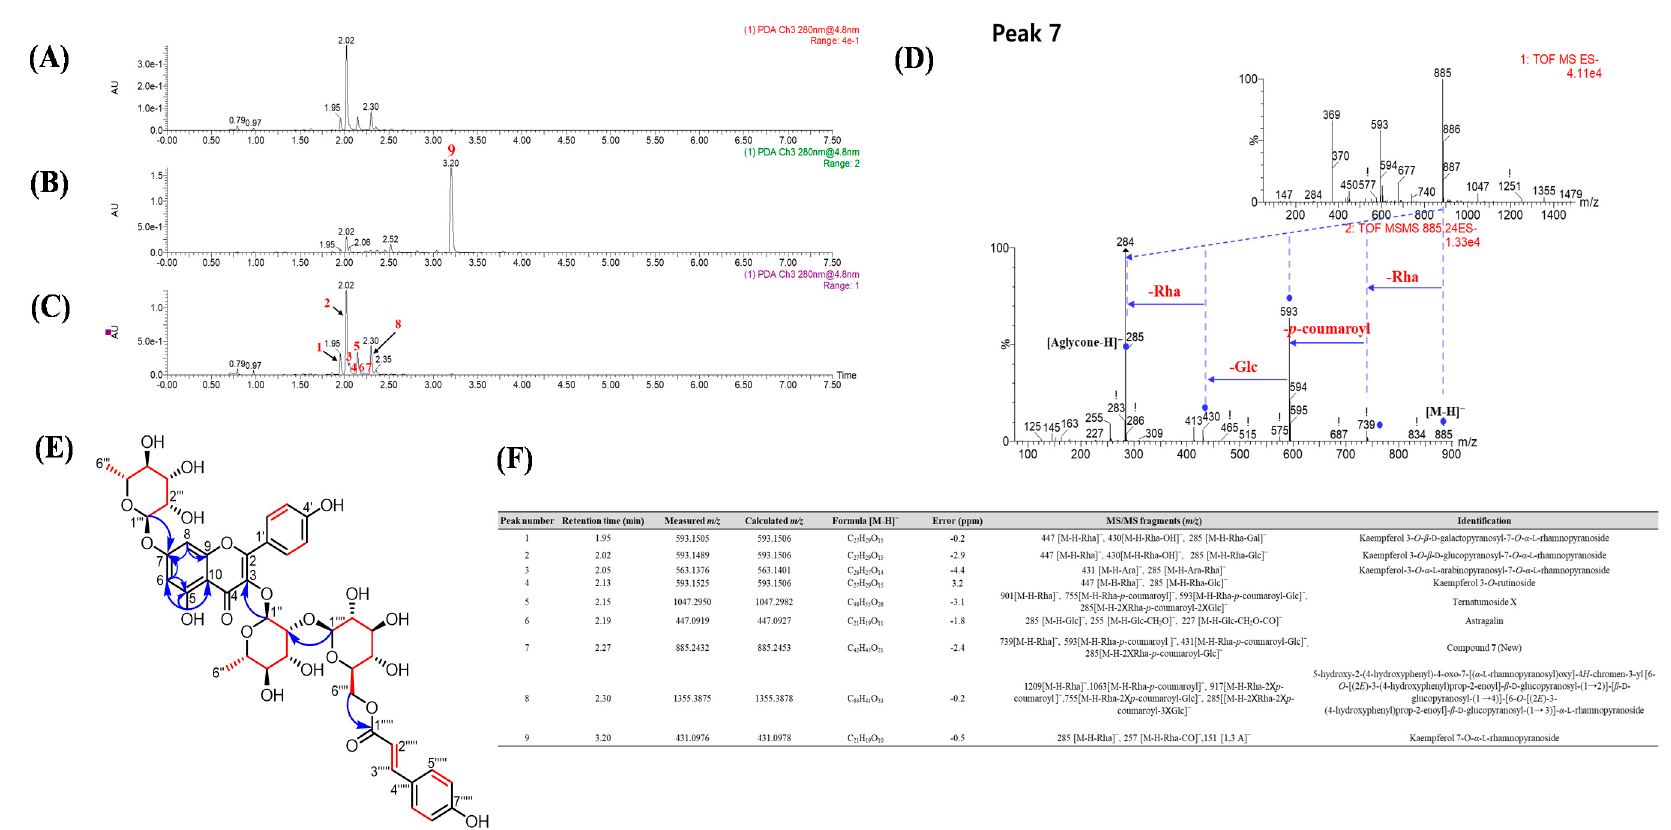
Figure 2. DAD (UV) chromatograms of ( A ) the crude extract, ( B ) the ethyl acetate (EA)-soluble fraction, and ( C ) the n -BuOH-soluble fraction of N. lappaceum seeds at 280 nm. Nine compounds ( 1 – 9 ) were quantitatively analyzed by UHPLC / ESI-qTOF-MS / MS in negative ion mode. The nine major compounds were isolated and their structures were determined by various spectroscopic techniques. ( D ) The fragmentation routes of compound 7 in N. lappaceum seeds. ( E ) Key HMBC (blue arrows) and the 1 H- 1 H COSY (red) correlations of compound 7 . ( F ) Peak assignment of the nine flavonol glycosides of N. lappaceum seeds.